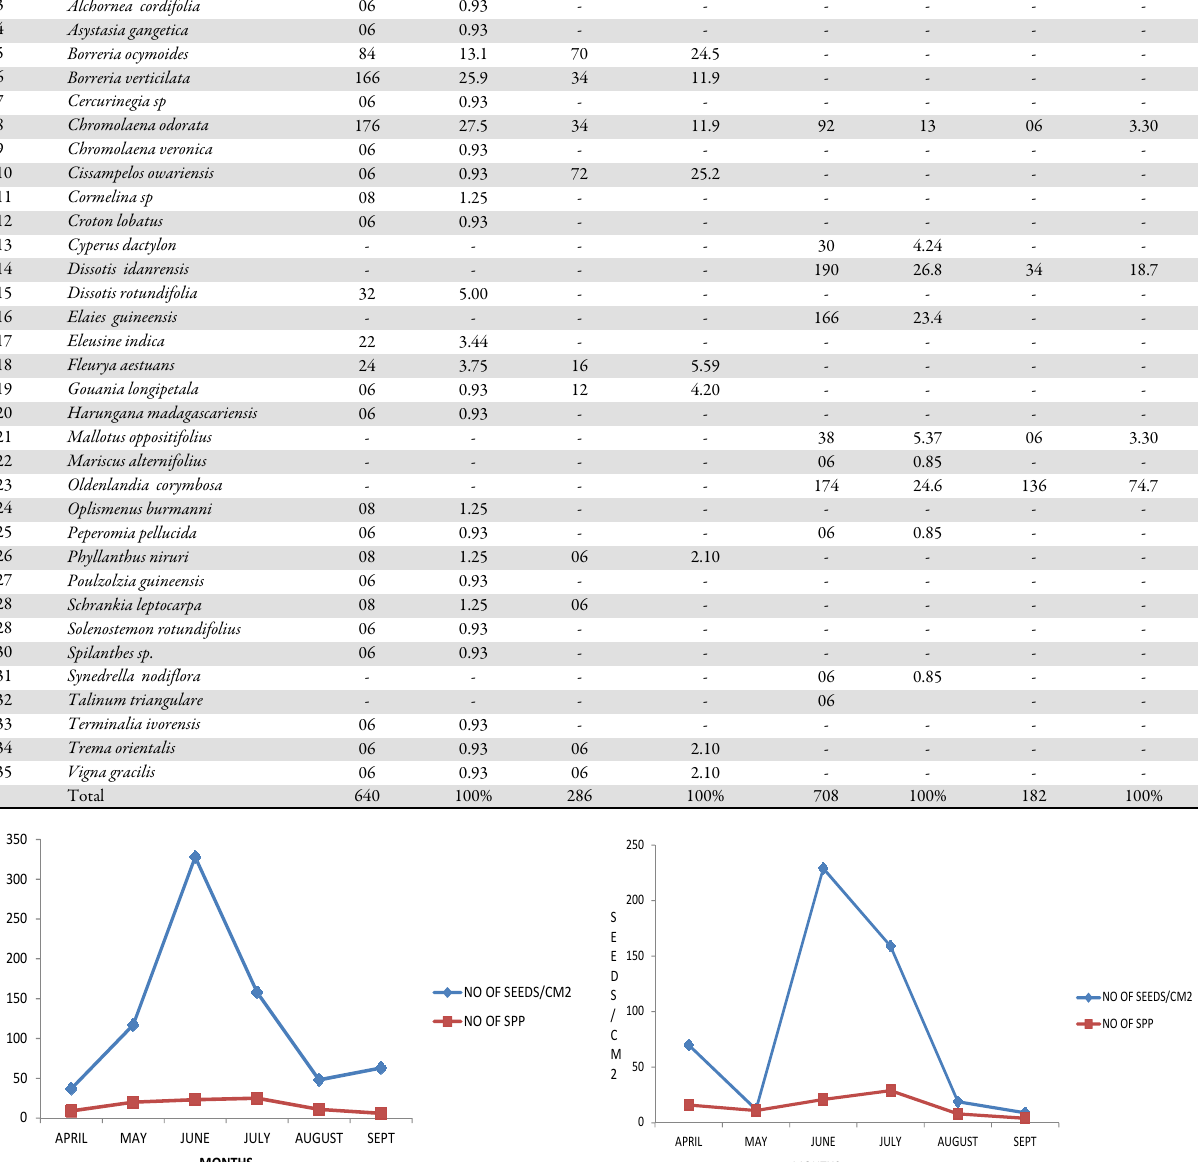
Croton lobatus Cyperus dactylon